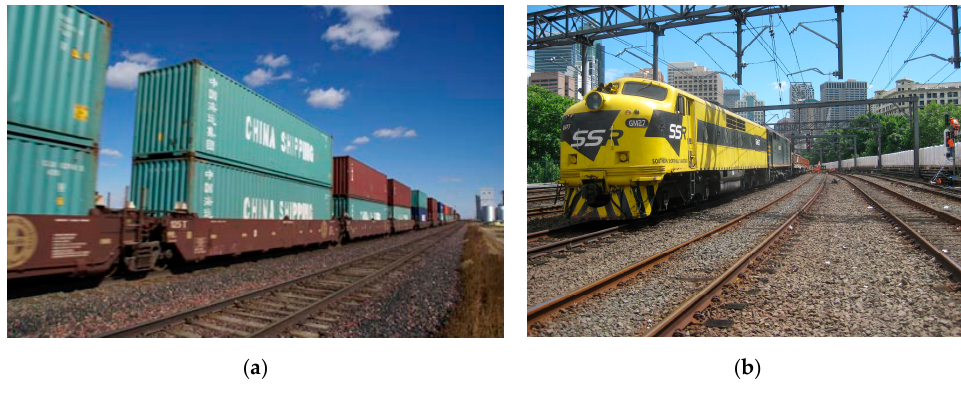
Figure 1. Freight train. ( a ) freight wagons; ( b ) locomotive.